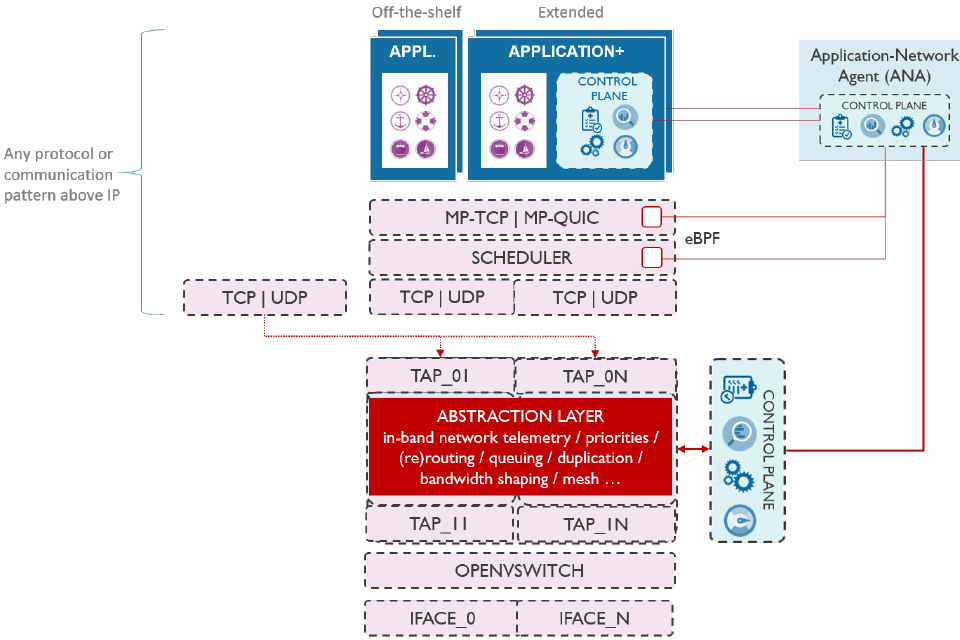
Figure 1. Communication architecture with the abstraction layer for traffic